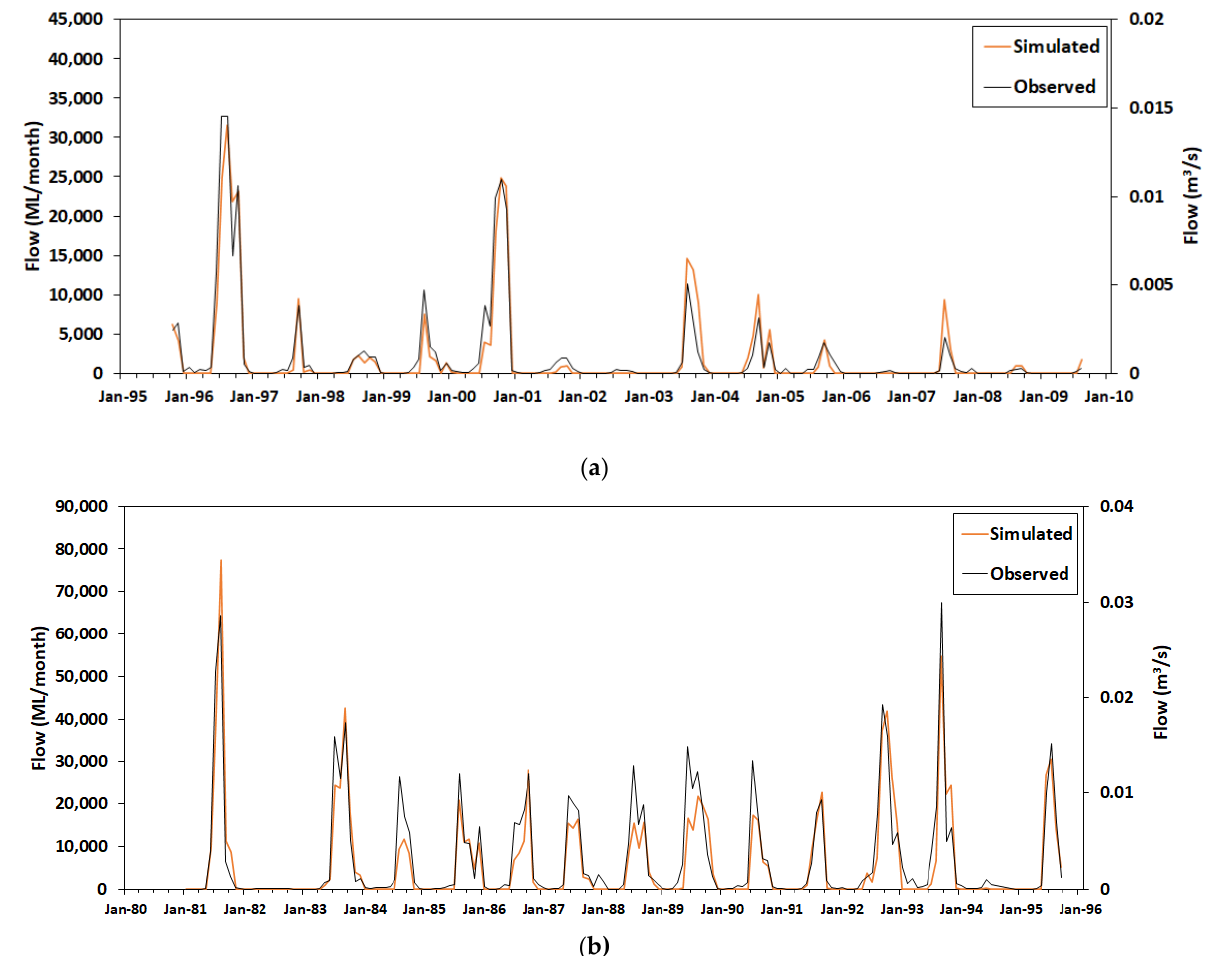
Figure 2. Time series plots of modelled and observed streamflow: ( a ) calibration period; ( b ) validation period.